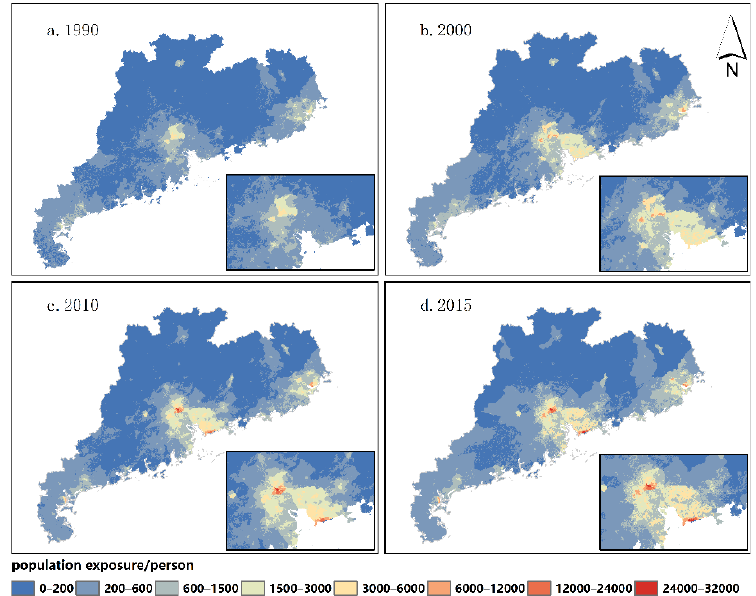
Figure 6. PSS in the summers of 1990 ( a ), 2000 ( b ), 2010 ( c ), and 2015 ( d ). The population exposure to climate discomfort overall significantly increased in all prefecture-level cities (Figure 7). Being the prefecture-level city with the highest popula- tion exposure to climate discomfort and the highest rate increase in Guangdong province, the increased rate of population exposure in Shenzhen was 2.94 million people/10 year and reached 9.29 million people in 2015. The rising rate of population exposure in Dongguan, Foshan, and Shantou was also high, around 1.7 million people/10 year, 1.19 million people/10 year, and 0.83 million people/10 year, respectively, and exceeded 5 mil- lion people in 2015 in each city. Because of the low population growth rate, the increase in population exposure to climate discomfort was relatively slow in Zhuhai, Chaozhou, Jieyang, Zhongshan, and other cities. Figure 7. PST (red line) and corresponding linear trend (blue line) during summer 1990 to 2018. Notes: All reach a significance level of 0.05.